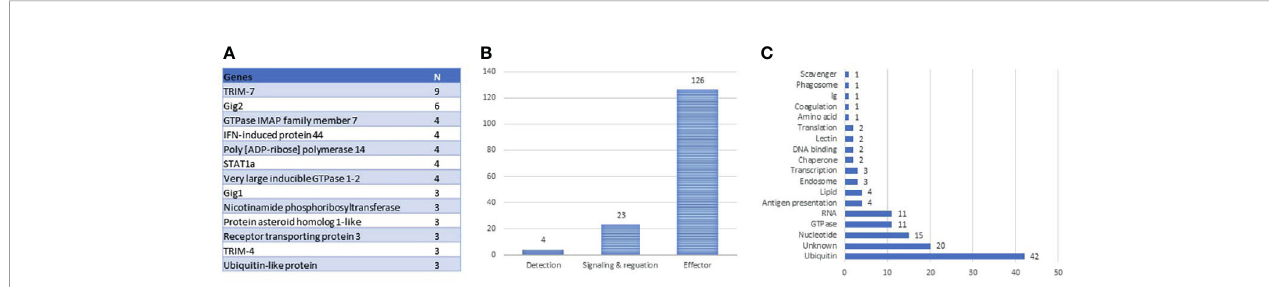
FIGURE 2 | Composition of antiviral TM (VRG). (A) genes with more than two paralogs and multi-gene families. (B) tiers of antiviral responses with numbers of genes. (C) distribution of antiviral effectors by roles.